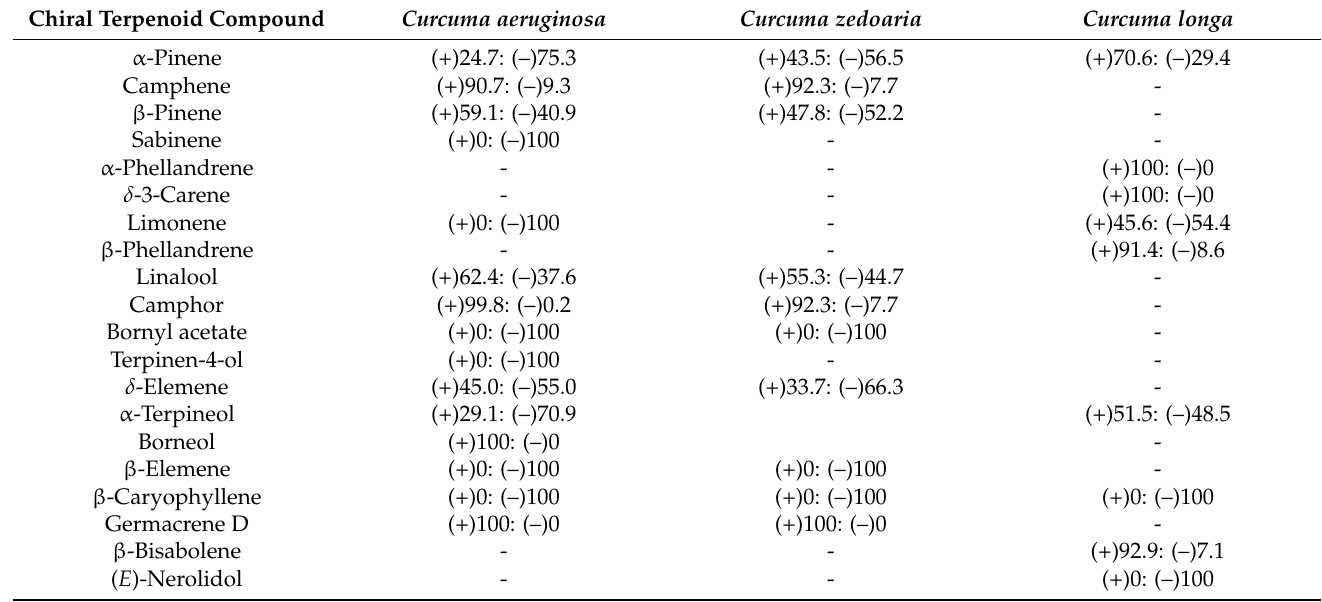
Table 3. Enantiomeric distributions of chiral terpenoids of Curcuma aeruginosa , Curcuma zedoaria , and Curcuma longa essential